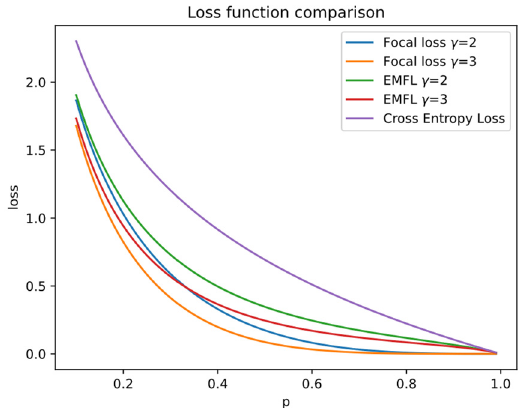
γ log ( p ) , EMFL: L = − ( 1 − p ) ( 1 − p )